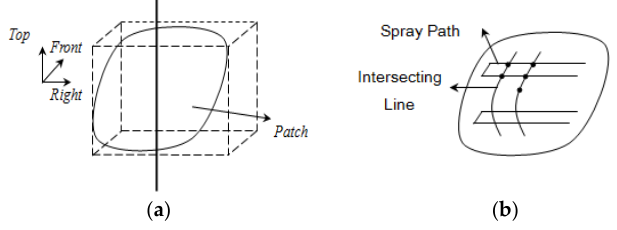
Figure 5. ( a ) The cuboid model; ( b ) The generated spatial path.